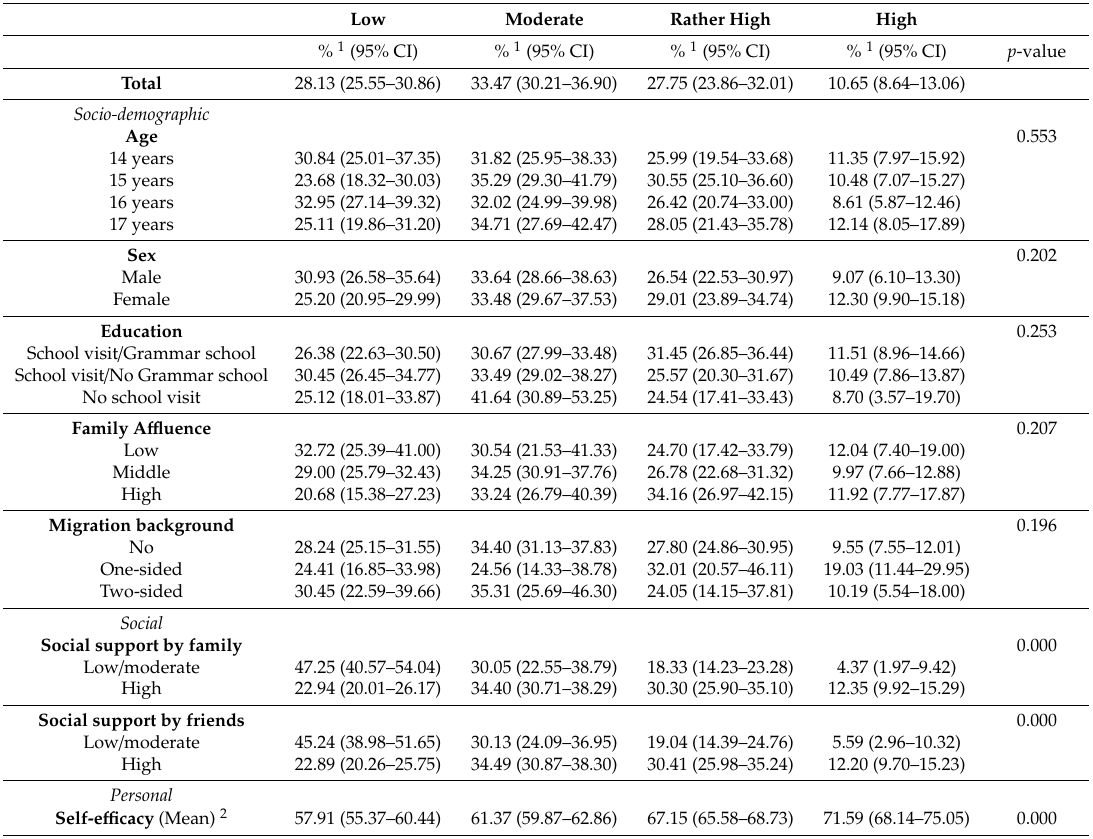
Table 4. Scale B: Weighted percentages and bivariate associations of level of health-related communication skills and considered factors among adolescents aged 14–17 ( n = 1202) based on GeKoJu 2019